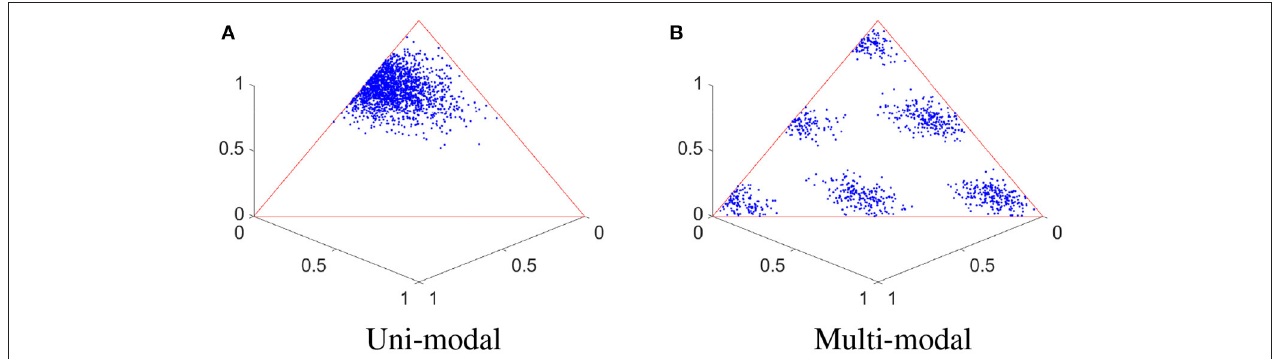
FIGURE 1 | Uni-modal and multi-modal IETs. (A) IETs of a two-event binomial process, with a uni-modal distribution. (B) IETs of another two-event binomial process, with a multi-modal